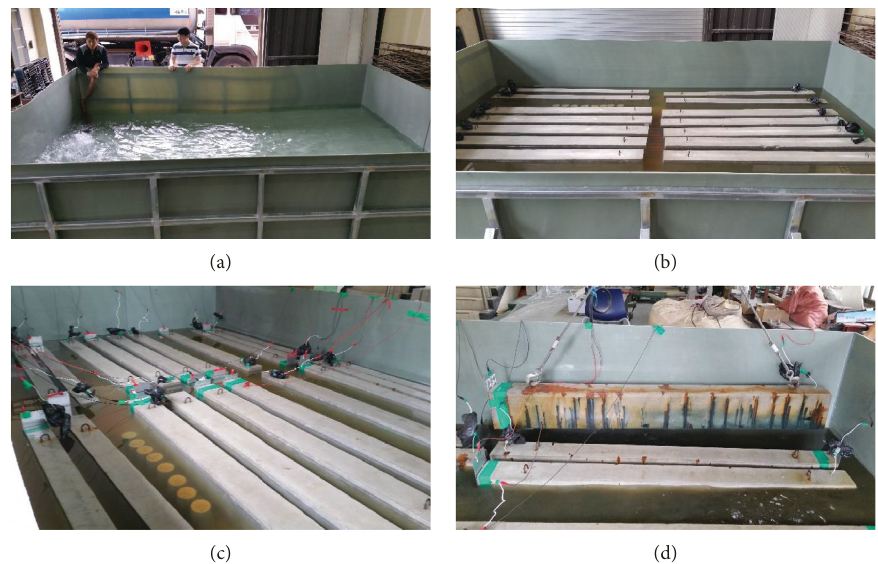
Figure 6: Accelerated corrosion setup: (a) tank with 5% NaCl solution, (b) immersion of beam, (c) accelerated corrosion, and (d) corroded beam.